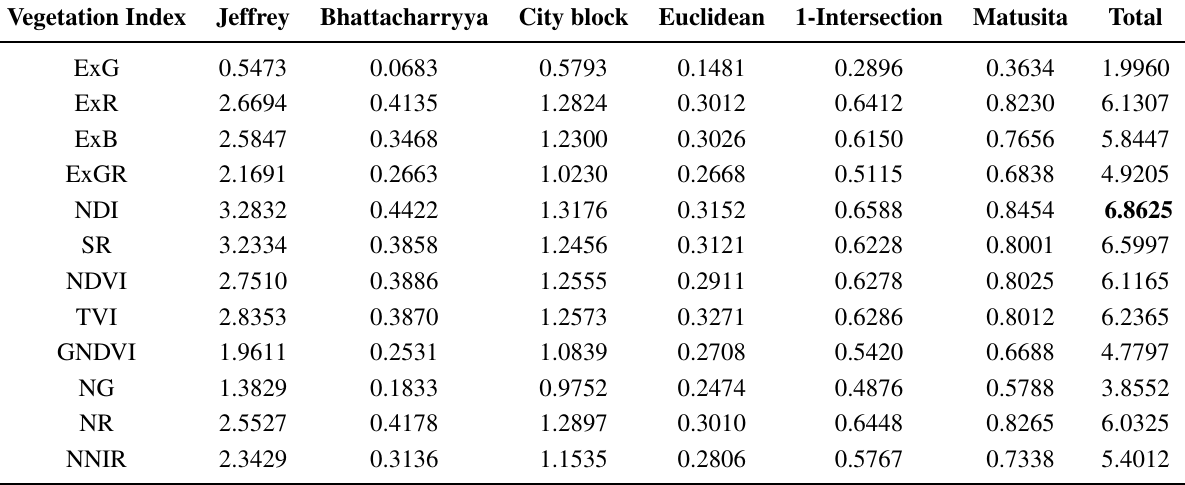
Table 2. Dissimilarity metrics comparing the histograms of oil palm tree and background using QuickBird